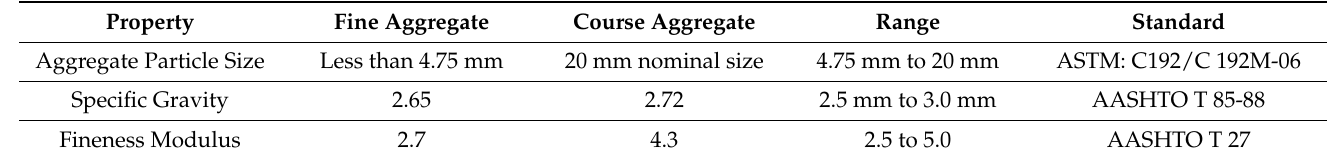
Table 2. Properties of